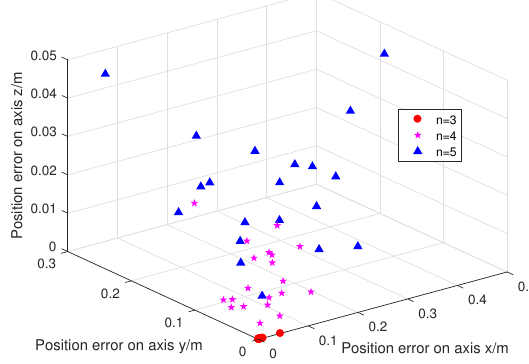
Figure 13. The error between the predicted and the actual coordinates at n = 3, 4, and 5.